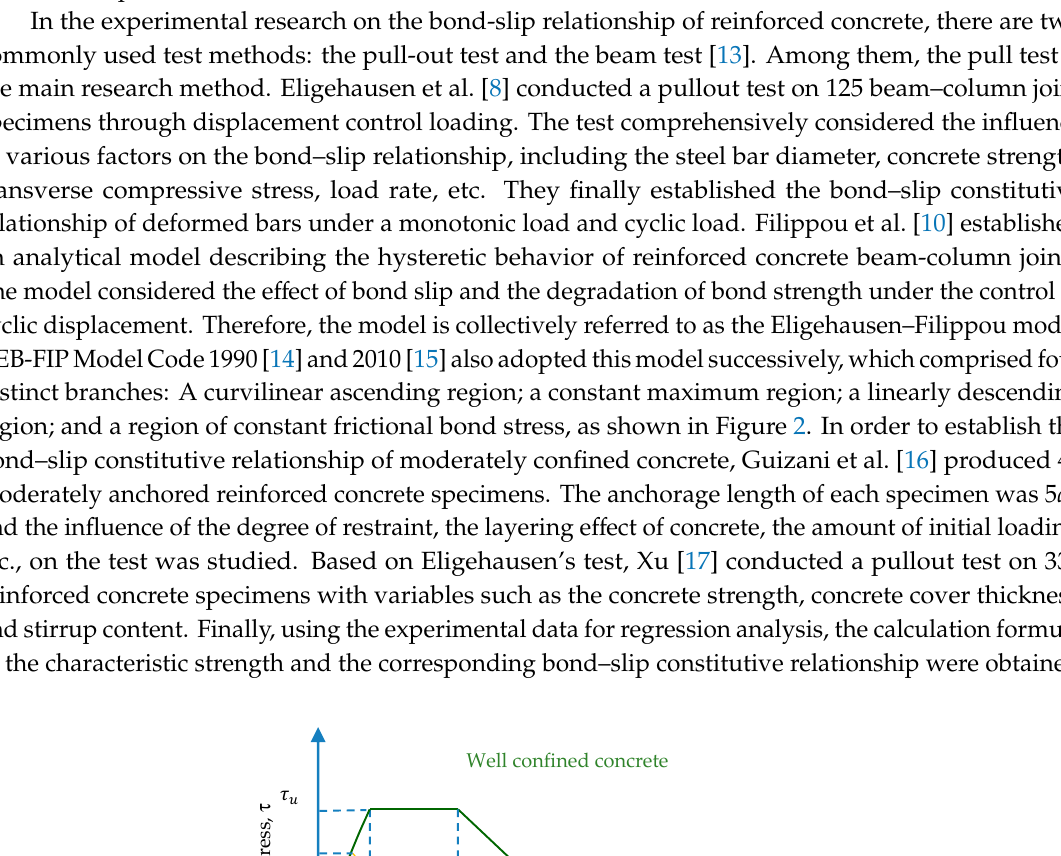
Figure 2. Comparison of bond–slip curves under different constraints.